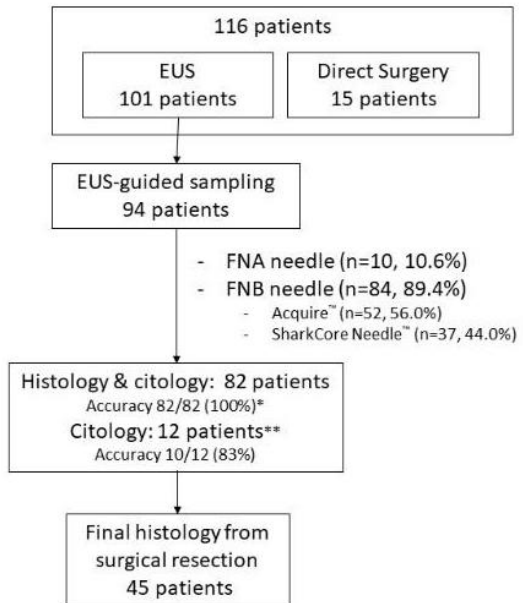
Figure 1. Study flowchart. * histology only accuracy 81/82 (98.8%), cytology only accuracy 73/82 (89.0%); ** no core obtained, but material adequate for cytological diagnosis.